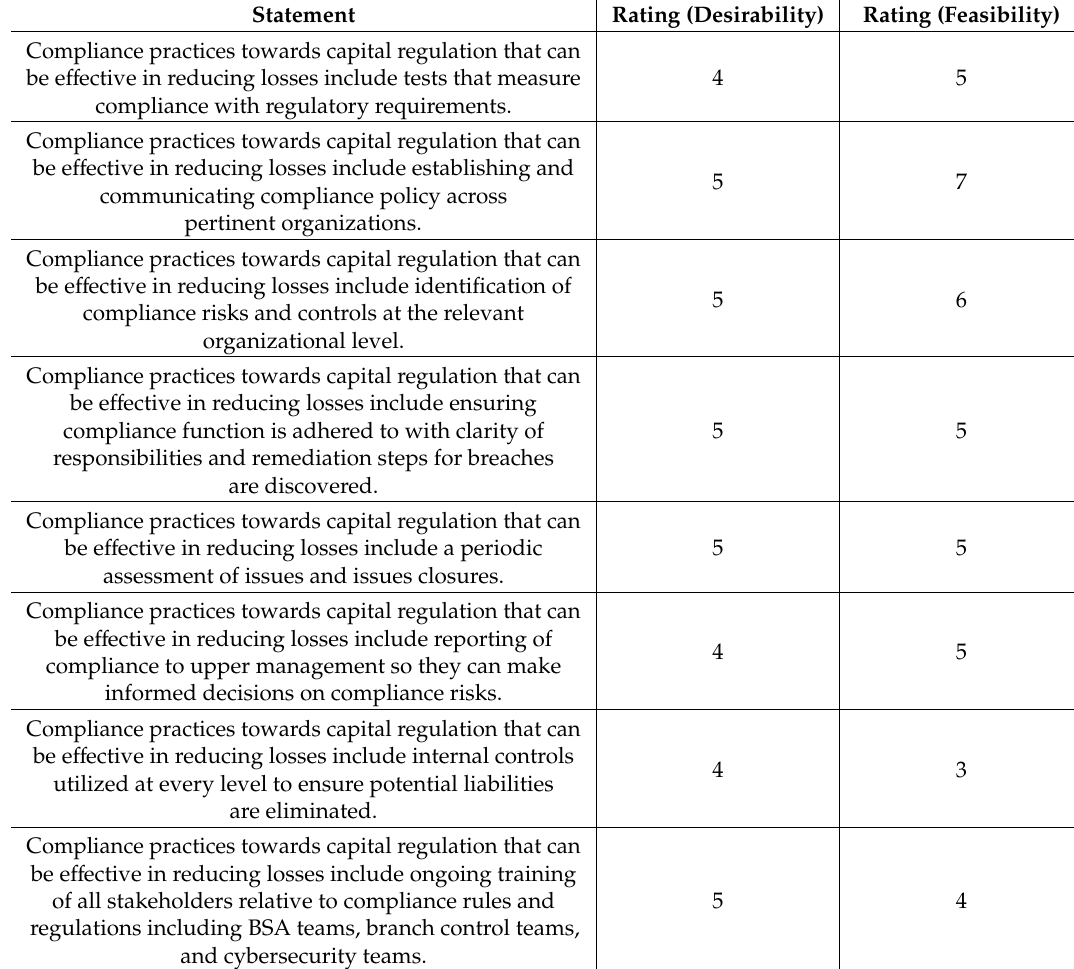
Table 2. Statements Failing to Meet Consensus Threshold in Round